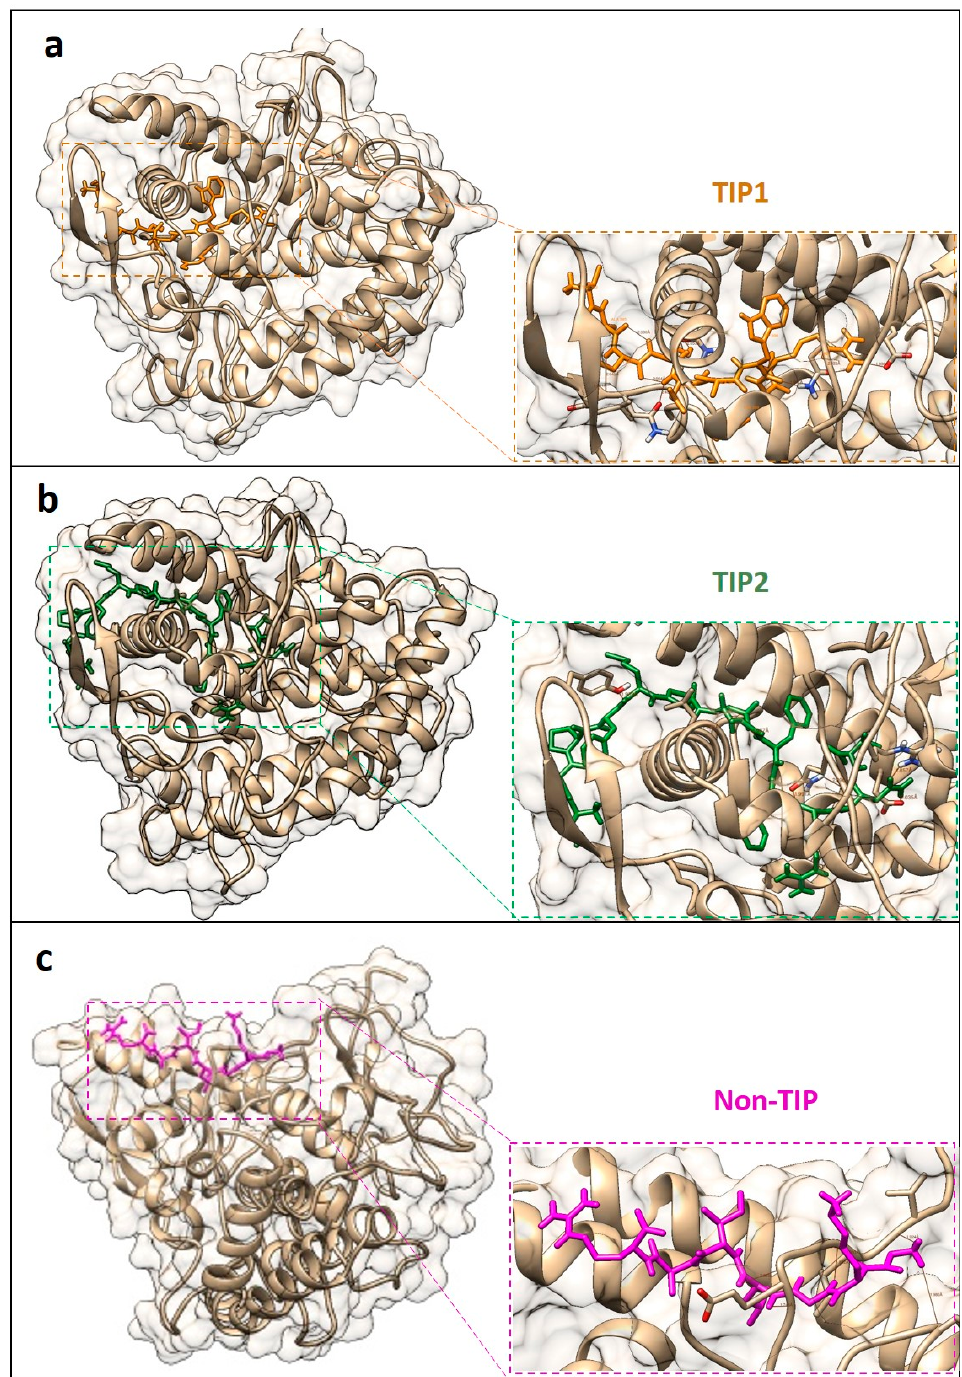
Figure 2. Molecular docking of two tyrosinase inhibitory peptides (TIP1 ( a ) and TIP2 ( b )) and non- tyrosinase inhibitory peptide (non-TIP ( c )) to the crystal structure of mushroom tyrosinase (PDB ID: 2Y9X). Structure of the mushroom tyrosinase is shaded in gray and the peptide sequences are colored as labeled above. The hydrogen bonds are shown as black lines.